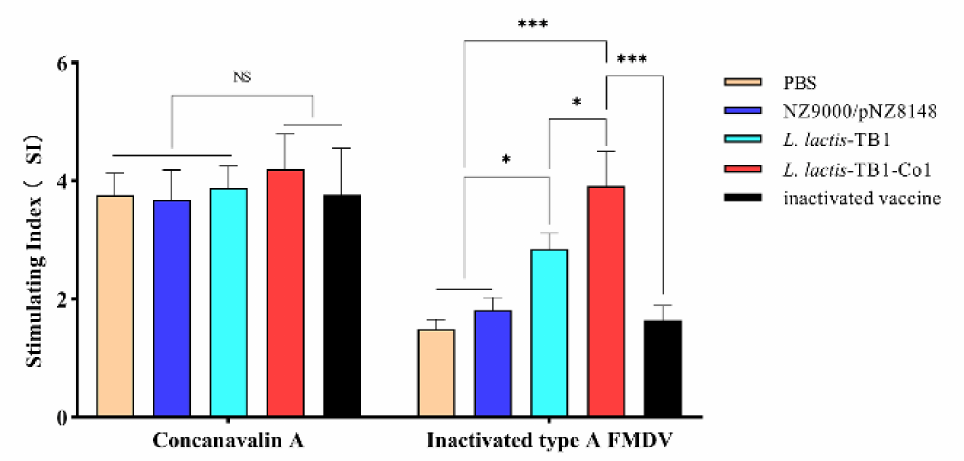
Figure 5. T lymphocyte proliferation levels. Splenic lymphocytes were obtained on day 30 post- vaccination and respectively induced with inactivated serotype A FMDV and concanavalin (ConA). Lymphocyte proliferation levels were evaluated by MTT colorimetric analysis. Stimulation index (SI) shows the ratio of OD 490 nm of stimulated wells to OD 490 nm of unstimulated wells. Data are presented as mean ± SD. Analyses were performed by two-way ANOVA test (NS = p >0.05; * p < 0.05; *** p <